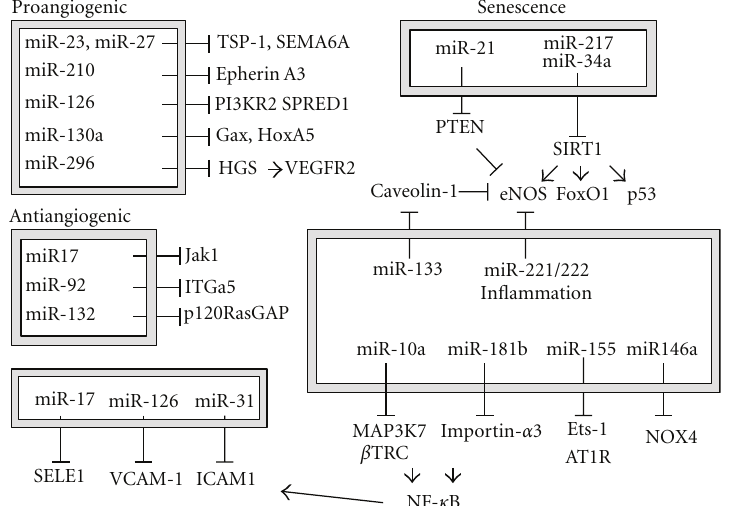
Figure 2: miRNAs regulate ECs functions. Schematic summary of endothelial miRNAs implicated in vascular inflammation. Senescence associated miRNA regulates SIRT1 or PI3K signaling. miRNAs directly involving in inflammatory response regulate angiotensin II signaling, redox signaling, and adhesion molecules. miR-146a suppresses NADPH oxidative subunit NOX4 expression [43]. Proangiogenic miRNAs (miR-23, -27, 210, 126, 130a, 296) and antiangiogenic miRNAs (miR-17, -92, -132) are also important for endothelial homeostasis